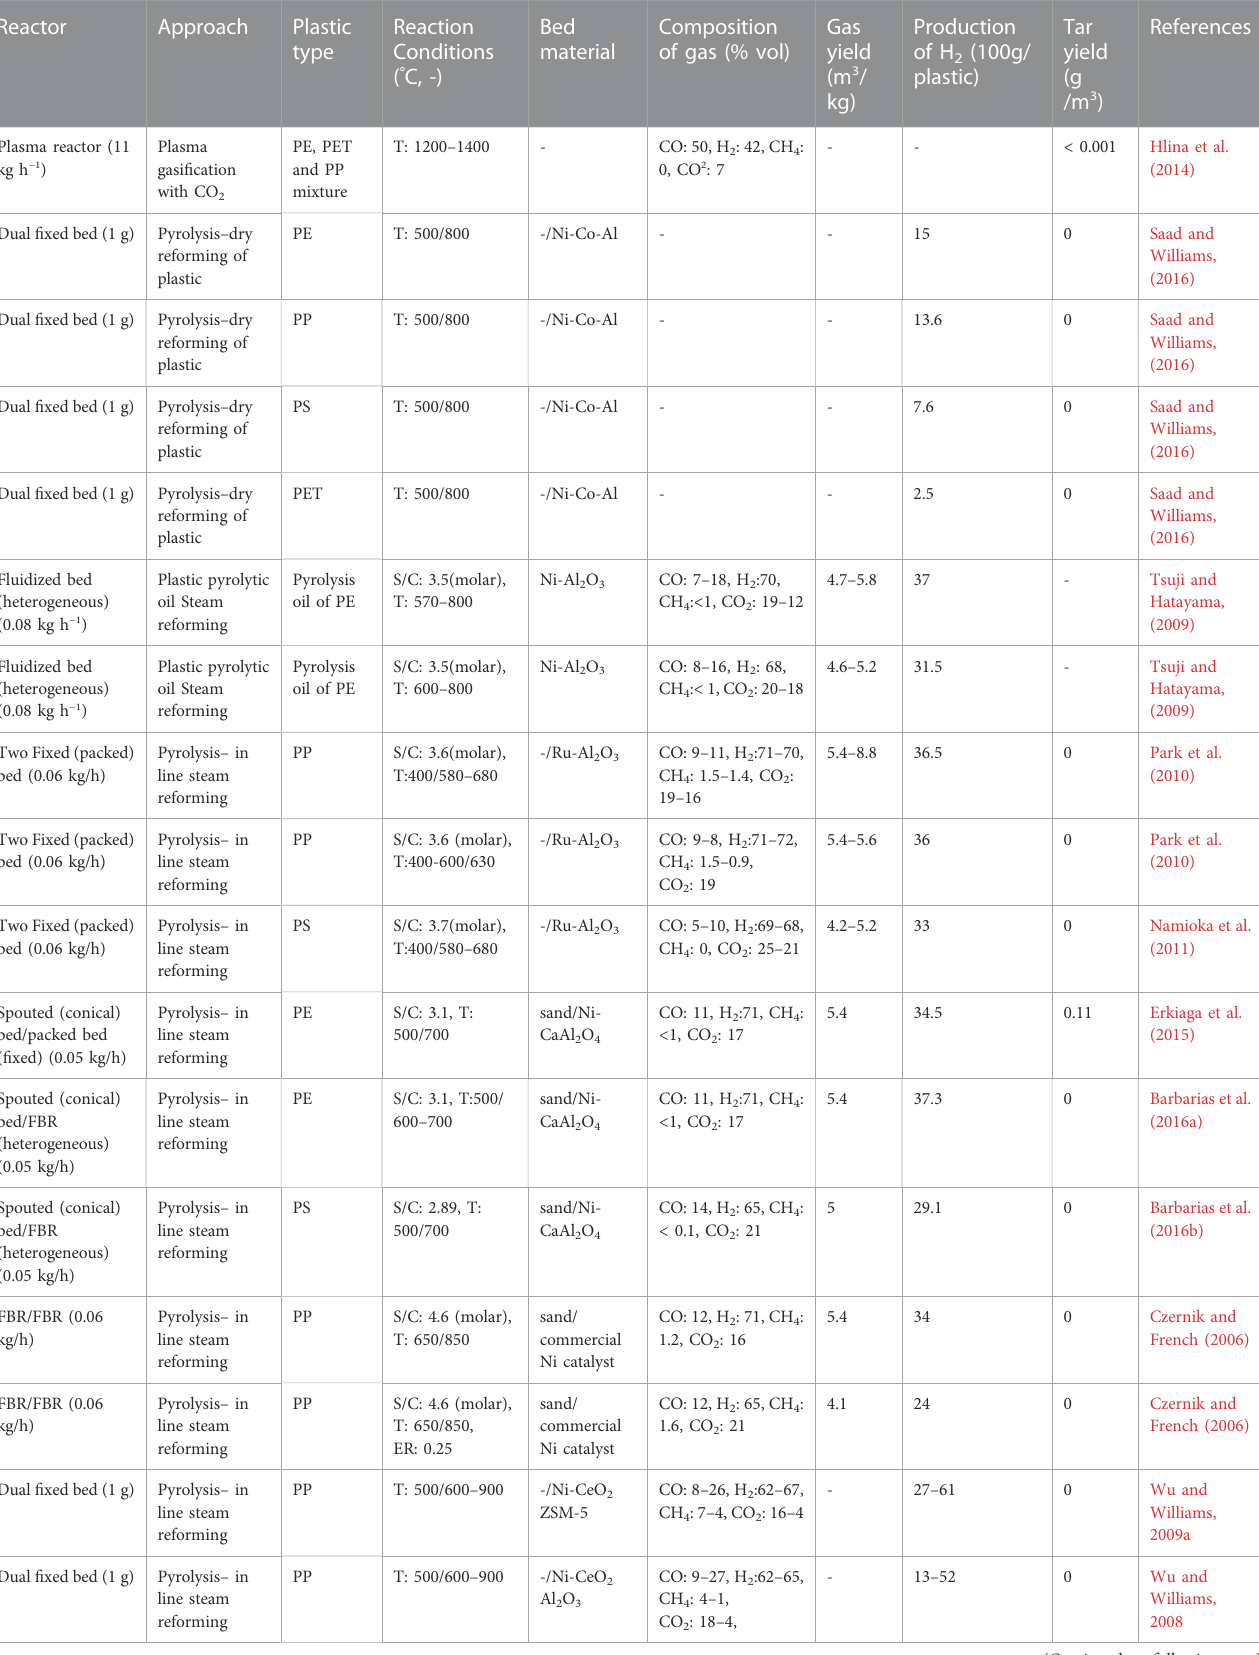
TABLE 10 Results obtained by different authors by using pyrolysis and steam reforming technique.